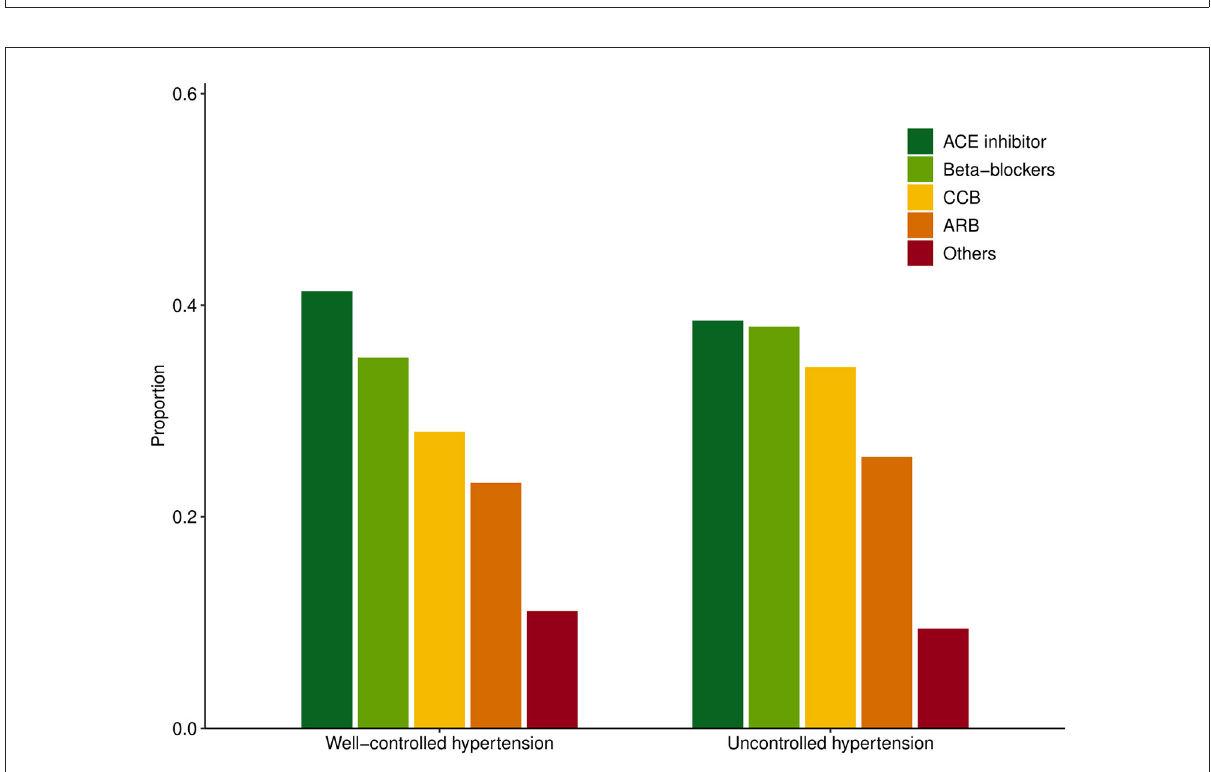
FIGURE3 Distribution of anti-hypertensives used in well-controlled hypertension and uncontrolled